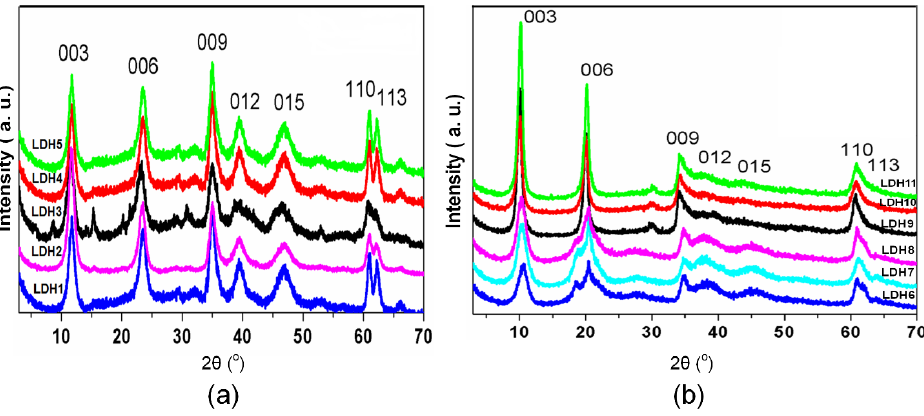
Figure 7 . XRD patterns (powder) of the prepared LDHs intercalated with: ( a ) CO 32 − ; ( b ) NO 3 − . Figure 7. XRD patterns (powder) of the prepared LDHs intercalated with: ( a ) CO 32 ´ ; ( b ) NO 3 ´